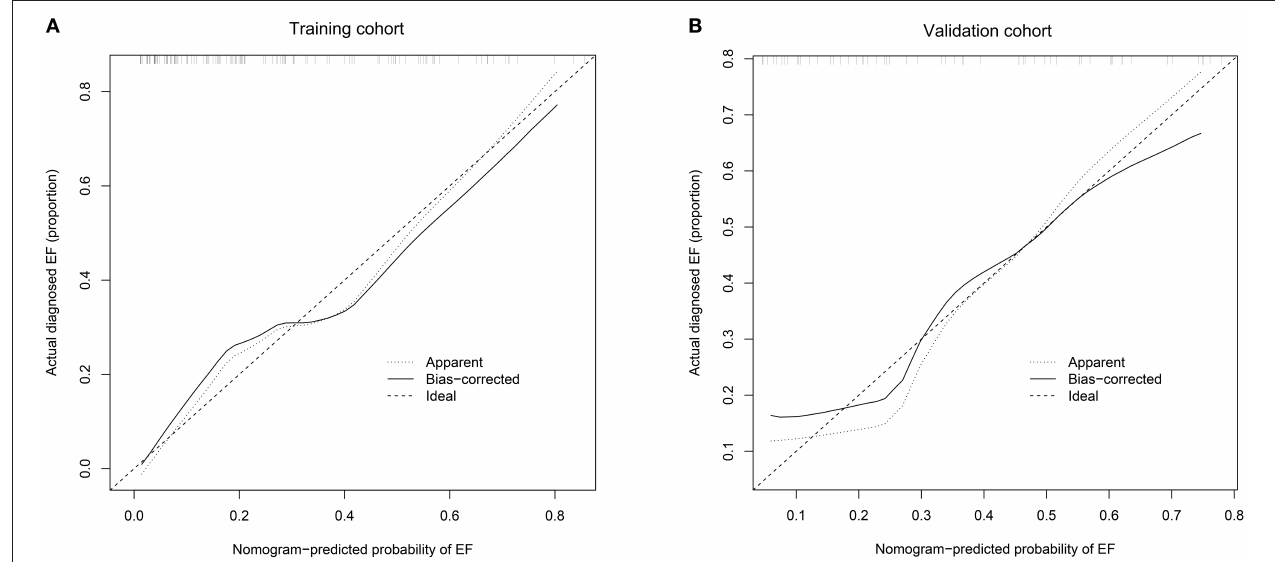
FIGURE 4 | (A) Calibration curves of the nomogram to predict extubation failure in training cohort; (B) Calibration curves of the nomogram to predict extubation failure in validation cohort. The horizontal axis shows the predicted probability of extubation failure, and the vertical axis shows the observed probability of extubation failure. Perfect prediction would correspond to the 45 ◦ broken line. The dotted and solid lines indicate the observed (apparent) nomogram performance before and after bootstrapping. EF, extubation